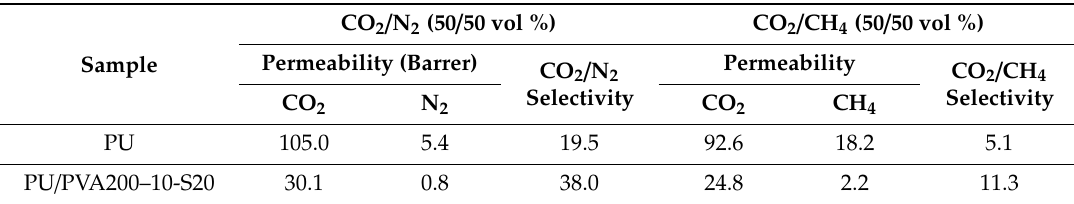
Table 3. Mixed gas separation properties of the membranes at 4 bar and 25 ◦